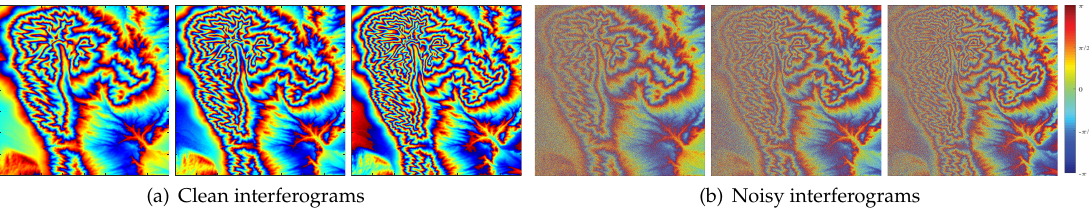
Figure 11. Clean interferograms and noisy interferograms generated by a mountain with coherence ranging from 0.1 to 0.9.